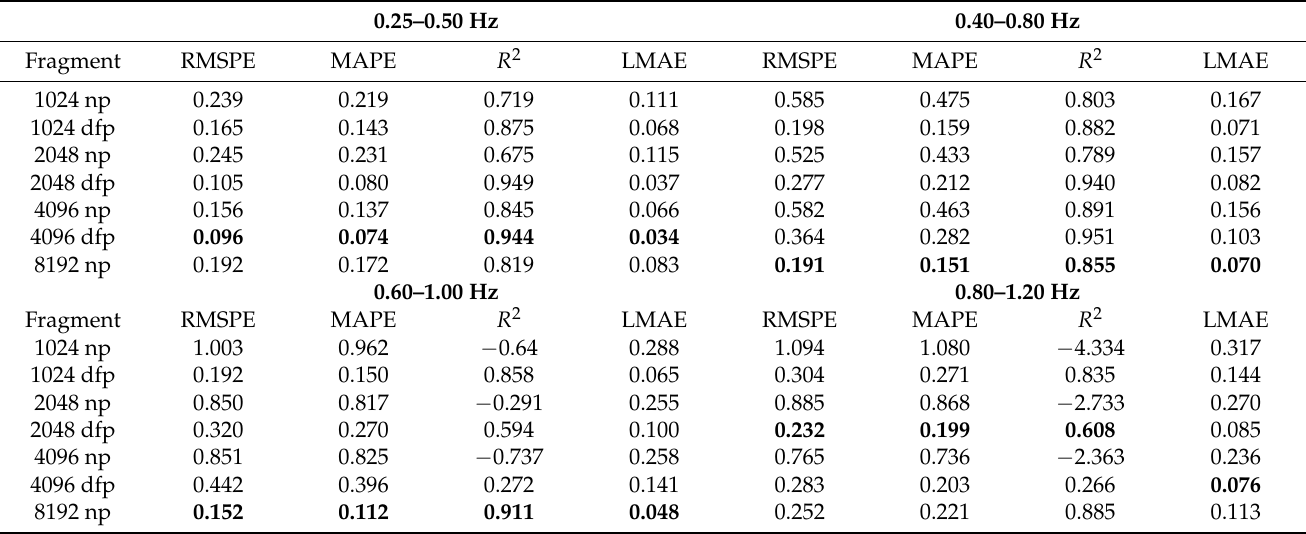
Table 3. Values of different quantitative measures of recovery performance in diverse fre- quency ranges.